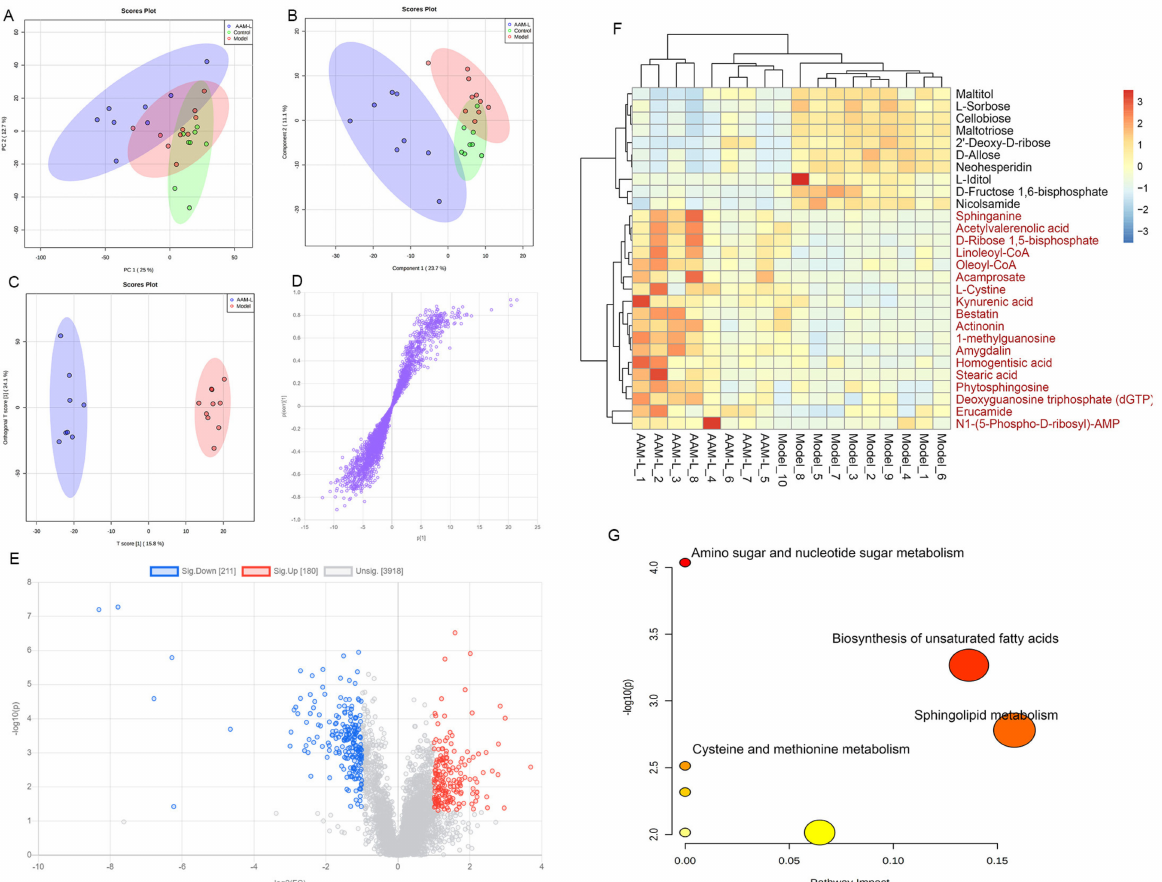
Figure 10. Liver metabolomic profiling by UPLC-QTOF/MS in the negative-ion mode (ESI-). ( A ) PCA score plot for the Control, Model and AAM-L groups; ( B ) PLS-DA score plot for the Control, Model and AAM-L groups; ( C ) OPLS-DA score plot for the AAM-L and Model groups; ( D ) S-loading plot based on the OPLS-DA analysis model of the Control and AAM-L groups; ( E ) Volcano Plot of significantly different metabolites between the Model and AAM-L groups; ( F ) Heatmap of relative abundance of significantly different metabolites (VIP value > 1.0, p < 0.05 and fold change > 2) between the Model and AAM-L groups; ( G ) Metabolic pathway impact prediction based on the KEGG online database. The -ln( p ) values from the pathway enrichment analysis are indicated on the horizontal axis, and the impact values are indicated on the vertical